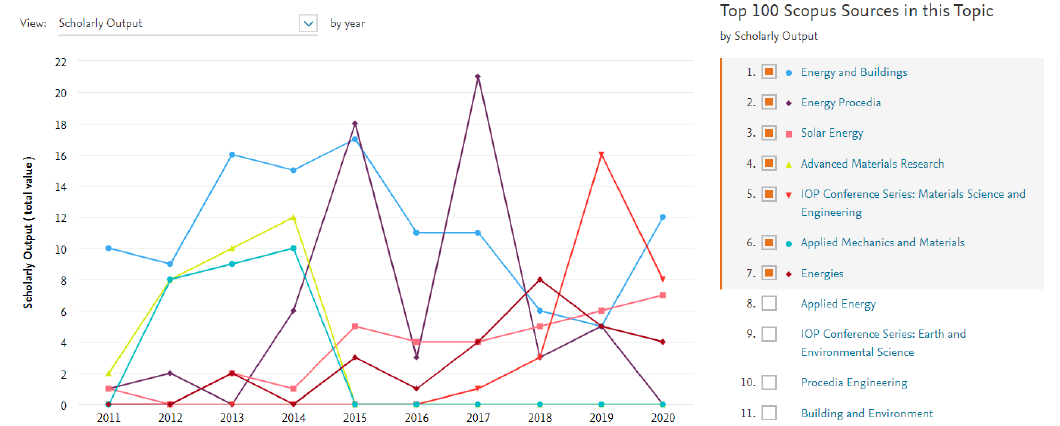
Figure 7. Most active Scopus Sources for topic «T.18162 Facades; Blinds; Natural Ventilation».